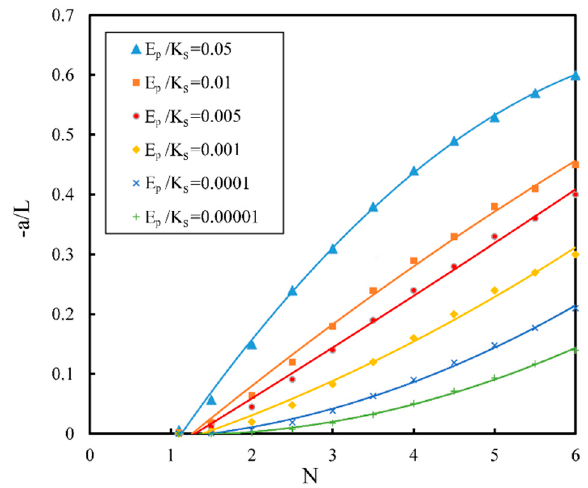
Figure 1. Different contours of E p / K s as a function of N and − a / L computed using Equation (11) (modified from Liu [38]).